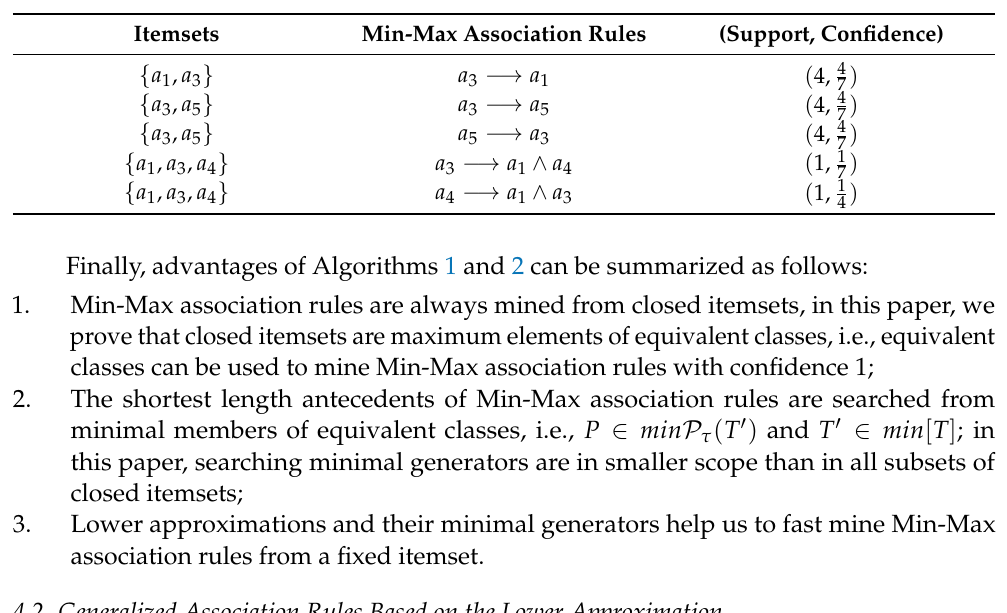
Table 8. Min-Max association rules generated by the